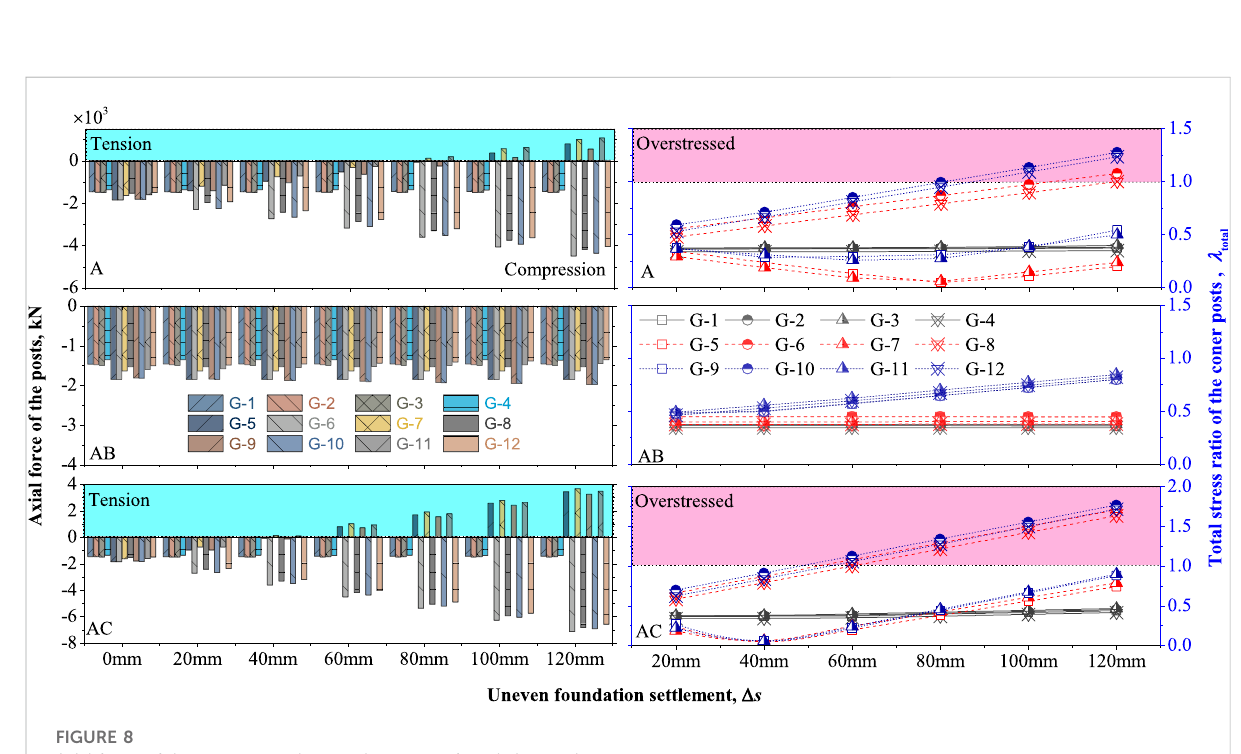
FIGURE 8 Axial force of the corner members under uneven foundation